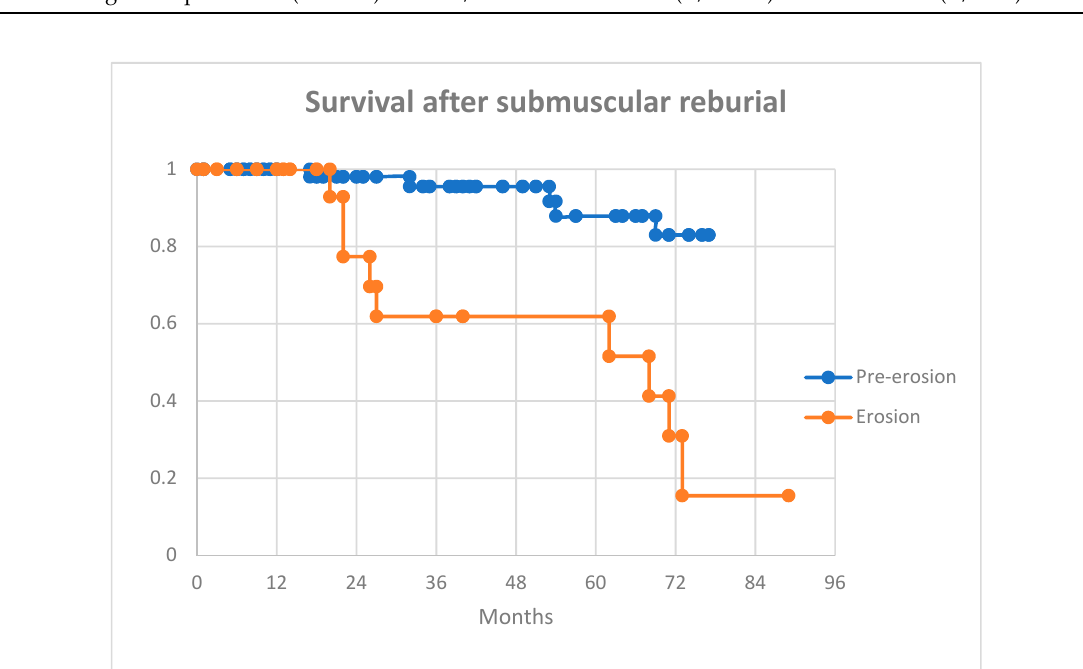
Figure 1. Kaplan–Meier curve of survival after submuscular reburial.